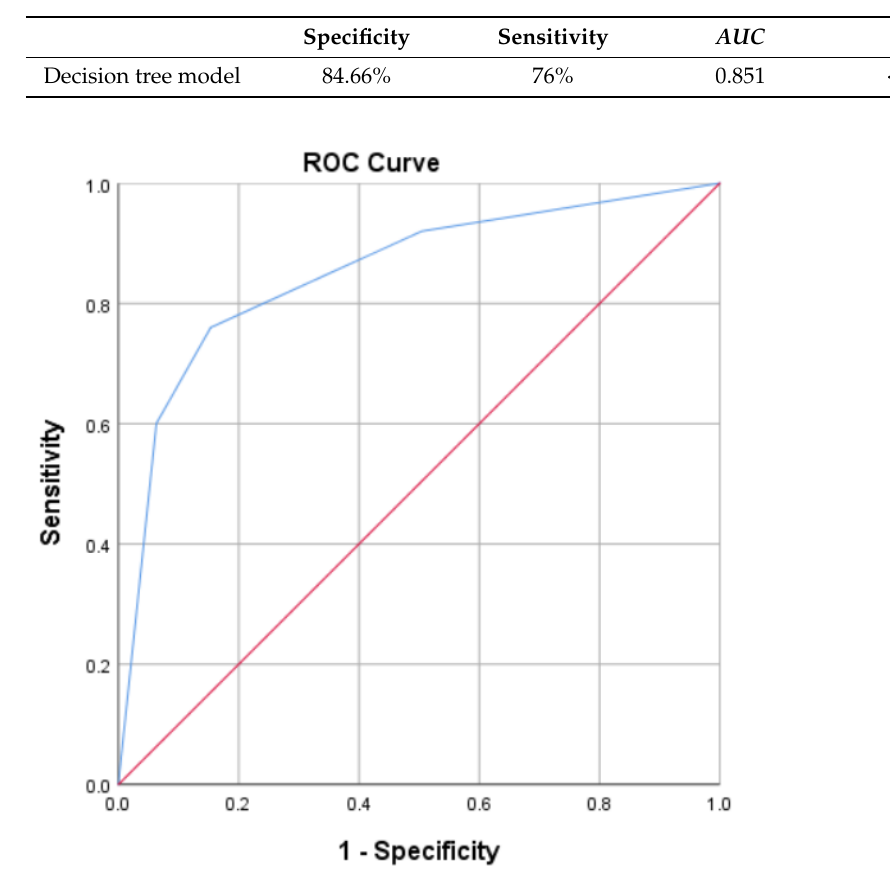
Figure 5. ROC curves of the decision tree model.